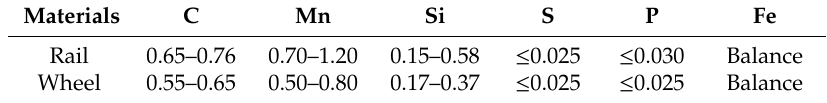
Figure 1. Sampling positions of the wheel/rail specimens. Table 1. Chemical constituents of rail and wheel materials (wt.%).